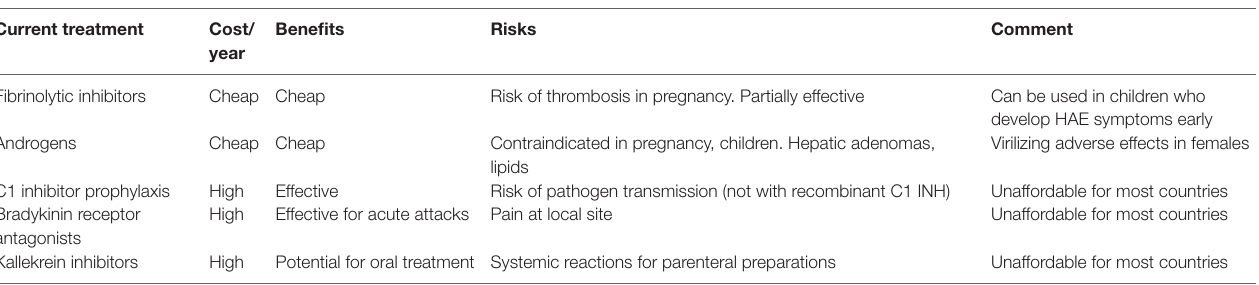
tAbLe 1 | comparison of currently available treatments for HAe types 1 and